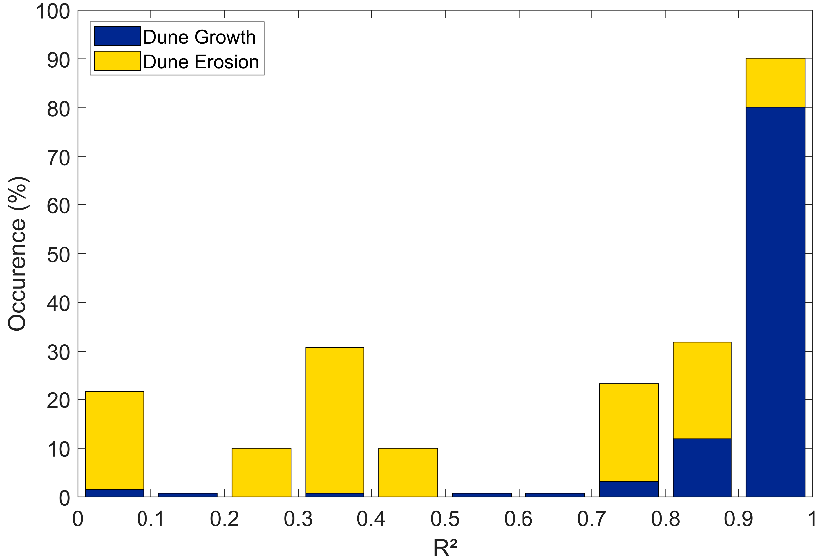
Figure 10. Density of occurrence of linear dune behavior. Of the dune sections, 80% show correlation coefficients larger than or equal to 0.9.